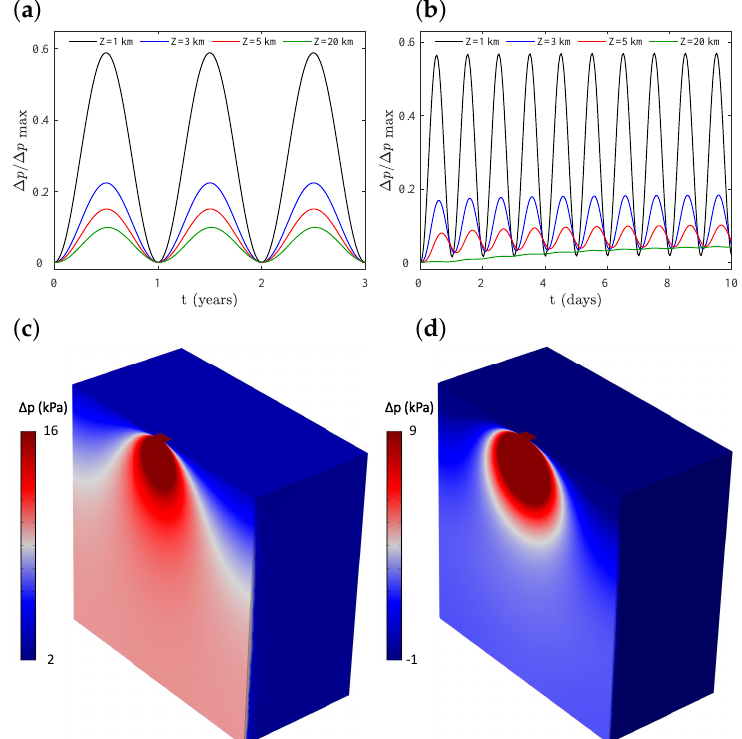
Figure 11. Impact of the reservoir operation on the pore pressure diffusion. We plot the results for a reservoir with annual regulation in the left column, and for daily regulation in the right column. On panels ( a , b ), we represent the ratio of the pore pressure build-up at 1, 3, 5, and 20 km depth to the maximum pressure on the bed of the reservoir. On panels ( c , d ), we show the distribution of the pore pressure build-up on the fault when the water level in the reservoir is maximum. The hydro-mechanical properties of the solid and water are listed in Table